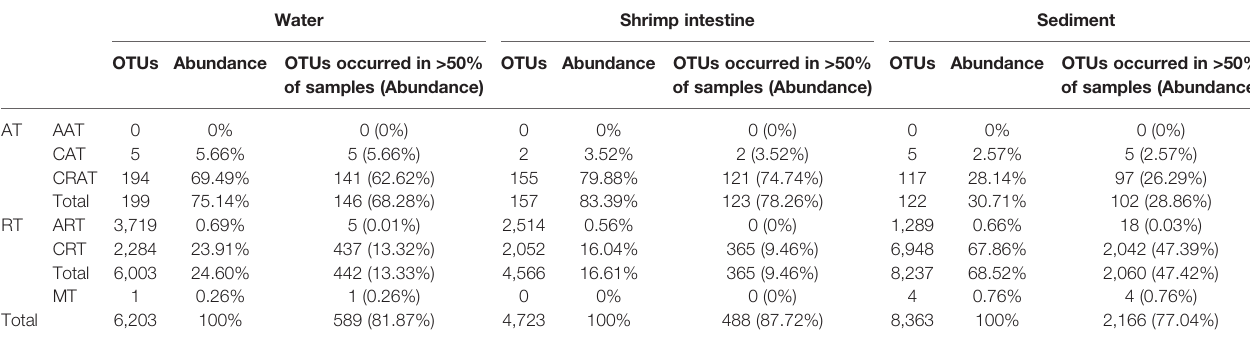
TABLE 1 | General description of abundant and rare microbial OTUs datasets in water, shrimp intestine and sediment habitats. Water Shrimp intestine